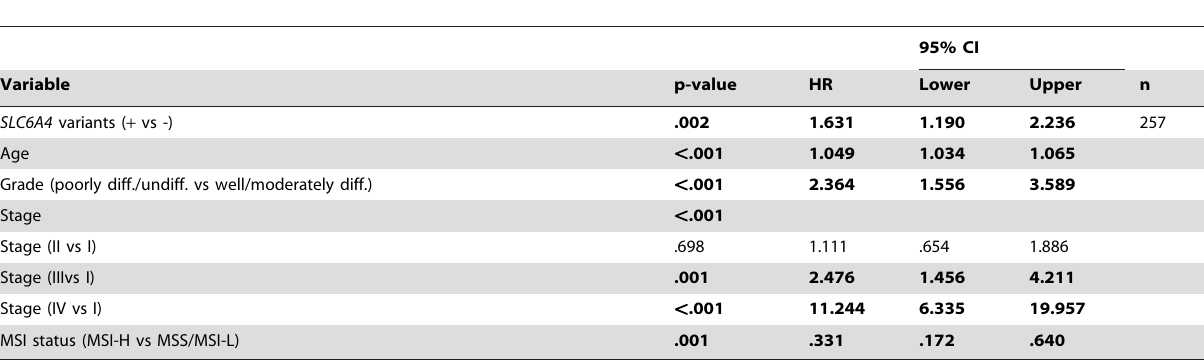
Table 5. Multivariate analysis results for the combined genotypes of three SNPs within the SLC6A4 gene (OS).